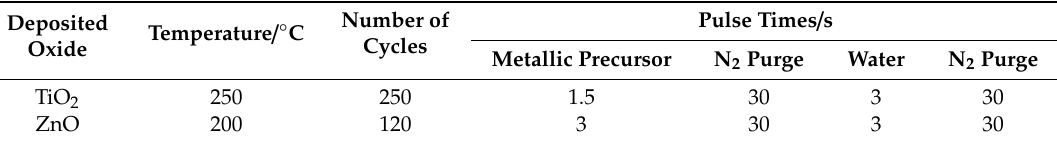
Table 1. ALD process parameters.